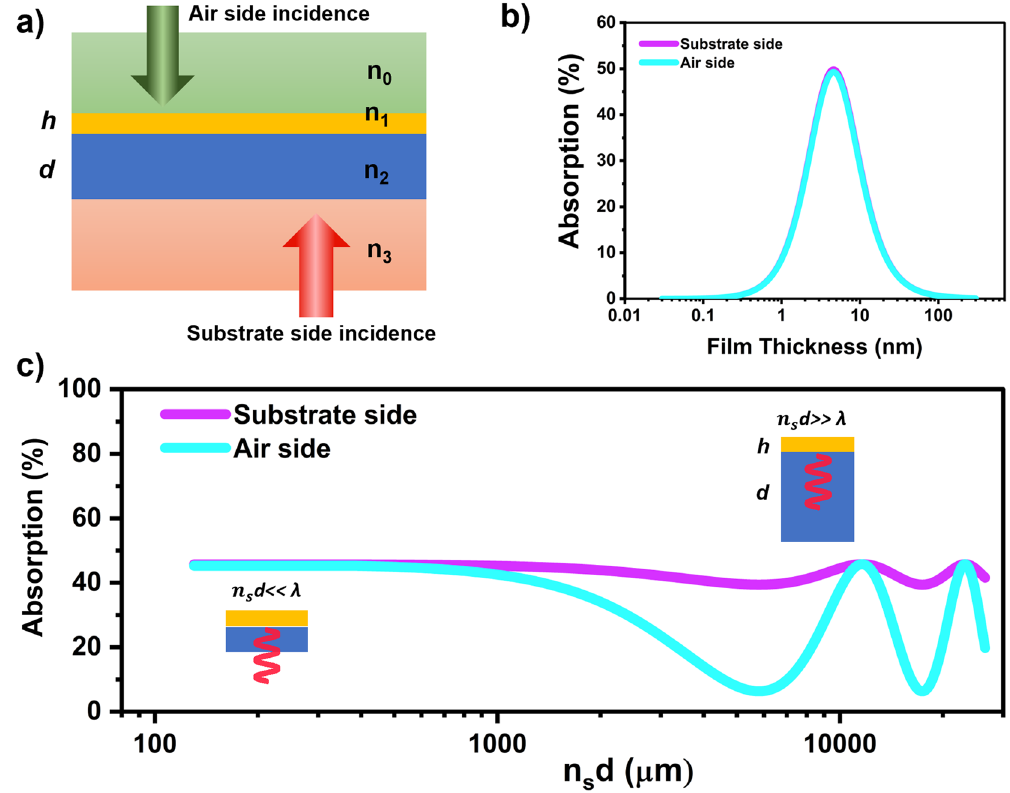
Figure 2. ( a ) Graphic description of the four-layer system for both air side and substrate side incident. ( b ) Absorption spectra by the four-layer system when the thickness of the substrate is very small compared to the wavelength (the axis of the film thickness is in the log scale), ( c ) absorption of the 6.5 nm gold film against the effective thickness of the glass substrate (n s d) in log scale (the insets show the schematic of thin and thick substrate related to the microwave